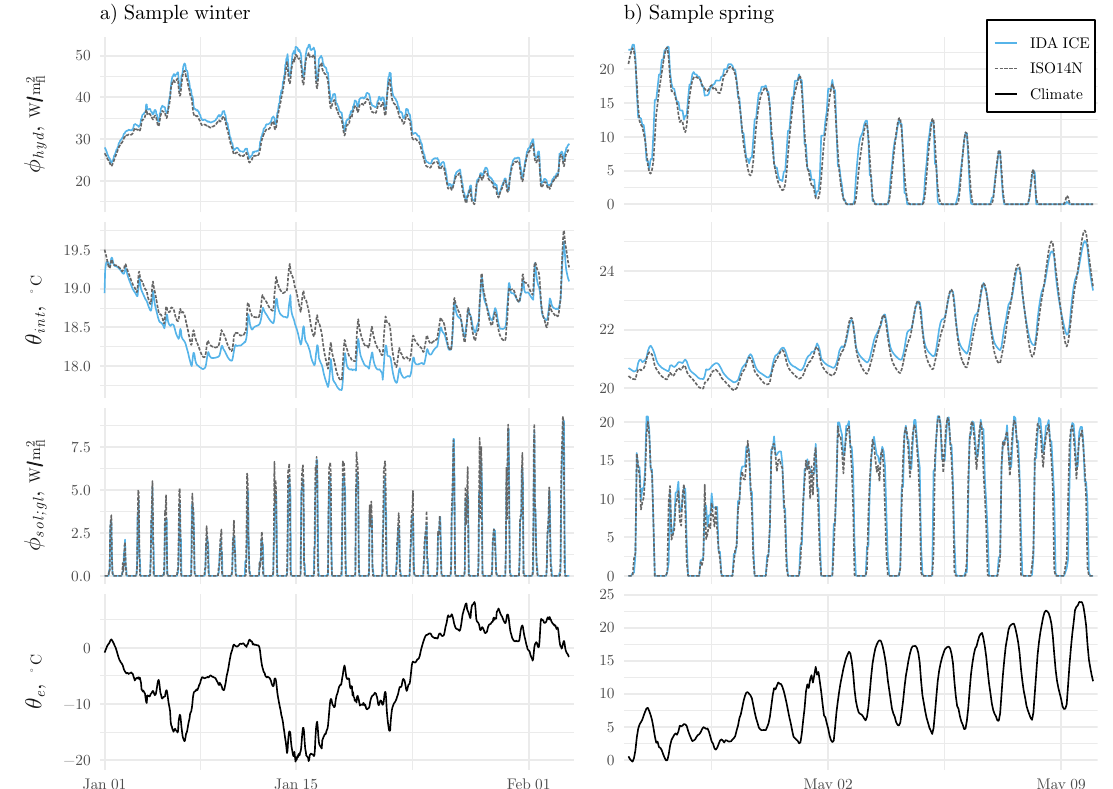
Figure 3. Hourly output variable comparison with IDA ICE. Diagram panels in column ( a ) shows a winter sample period, column ( b ) shows a spring sample period. Diagram panel rows compare following variables: energy use for space heating ( φ hyd ), internal air temperature ( θ int ), solar heat gains through glazing ( φ sol ; gl ), and external air temperature ( θ e